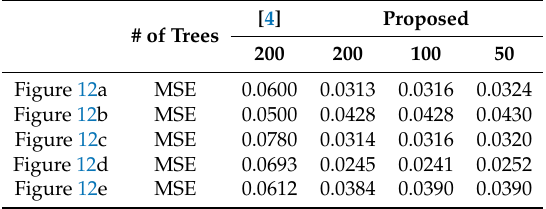
Figure 12. The test images used for the objective assessments of the performance of transmission estimation [23]: ( a )-( e ) are the real outdoor haze-free images of size 3873 × 2516. The haze image can be synthesized using corresponding depth map of the haze-free image. Table 3. Comparison of the objective assessments of the transmission estimation using random